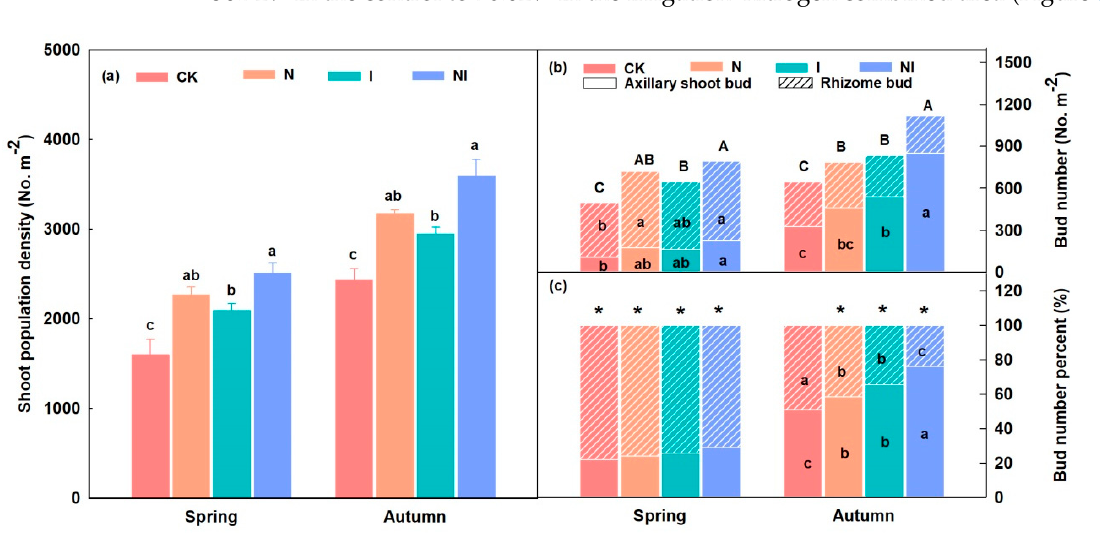
Figure 3. Different treatment effects on the shoot population density ( a ), the number of the two types of buds ( b ) and the percentage bud number ( c ) in different seasons (average of the two years). The capital letters indicate that there were significant differences between total bud number in the different treatments. The lowercase letters indicate that the same type of buds had significant differences in different treatments. * indicates that there were significant differences between two types of buds in the same treatment. Shown are the means ± 1 SE ( n = 4). Different letters denote a p < 0.05 difference based on an LSD post hoc multiple comparison test. (CK, control; N, nitrogen application; I, irrigation; NI, irrigation and nitrogen application).